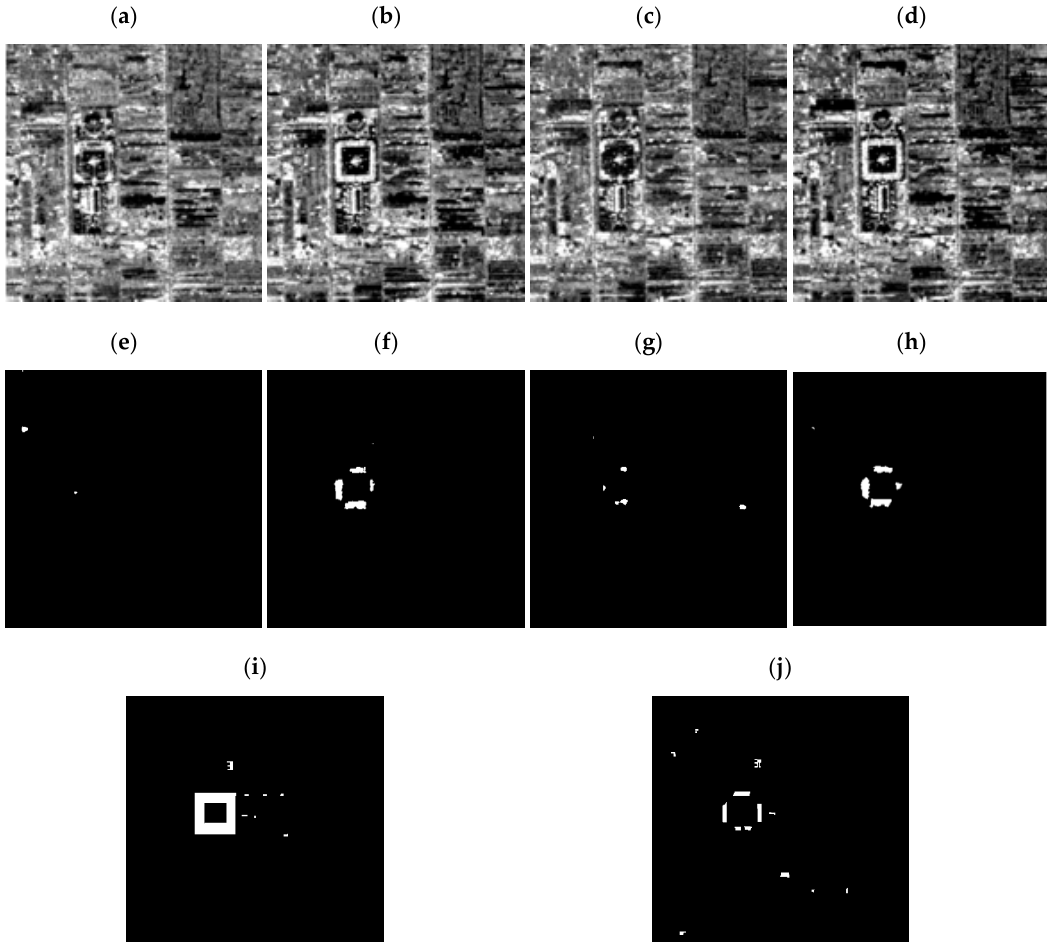
Figure 8. Comparison between each patch size in the second area of the Bangkok site. The resolution of each image is 6 km × 6 km (for SAR pairs 27 November 2008/15 January 2010 and 12 January 2009/21 November 2009, respectively: ( a , c ) Time 1 SAR image, ( b , d ) Time 2 SAR image, ( e , g ) result of 128 × 128 patch size, ( f , h ) result of 256 × 256 patch size, ( i , j ) ground truth). The results in Table 4 indicate that using a 256 × 256 patch size leads to better accuracies. As a result, we decided to use a patch size of 256 × 256 in all experiments. A 256 × 256 patch size results in better accuracies because a 128 × 128 patch size is too small, causing the loss of features of some parts, such as paddy fields, and leading to the network’s inability to fully learn the change pattern of these areas. Even though the negative part is not the focus of this study, it is indispensable for network training, which can be more recognizable in a 256 × 256 patch size. Moreover, because the sliding step in patches cutting is smaller in a 128 × 128 patch size, the cut patches would have too many repetitive patterns of both positive and negative features, which can cause the model to be overfitted at an early stage. Table 4. The accuracy of a 128 × 128 patch size compared with a 256 × 256 patch size on the Bangkok testing site.